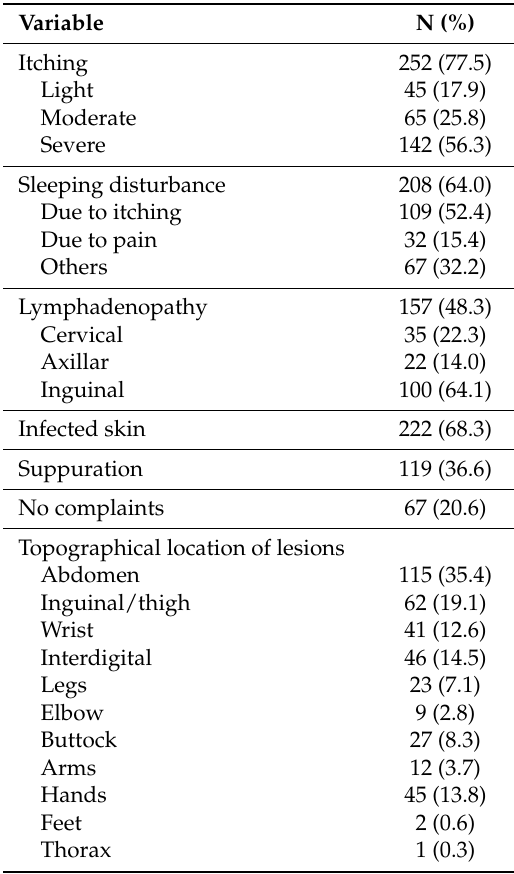
Table 3. Clinical features and topographical location of scabies infestation ( n = 325).